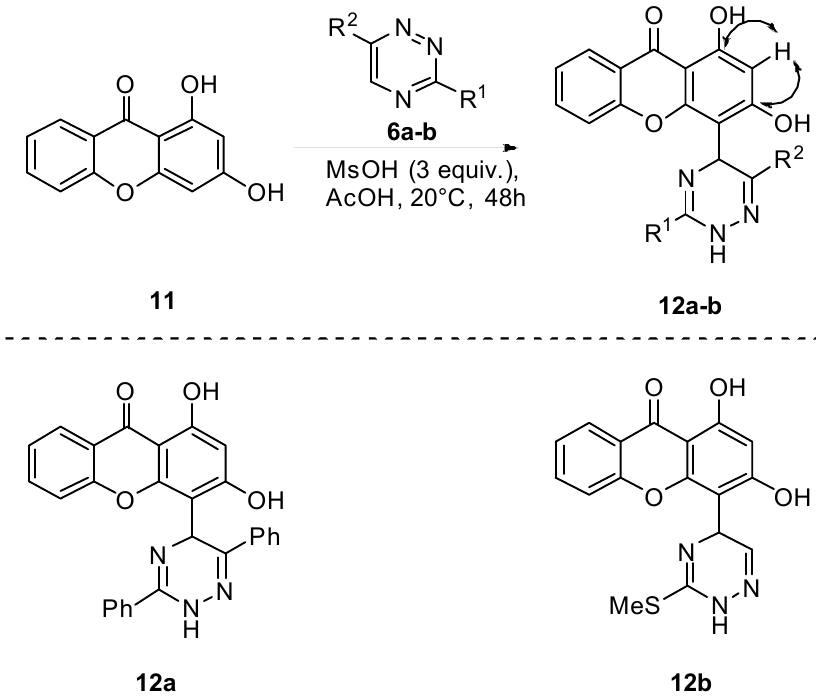
Scheme 5. Synthesis of dihydrotriazine-substituted 1,3-dihydroxyxanthones 14a – b and 15a – b .